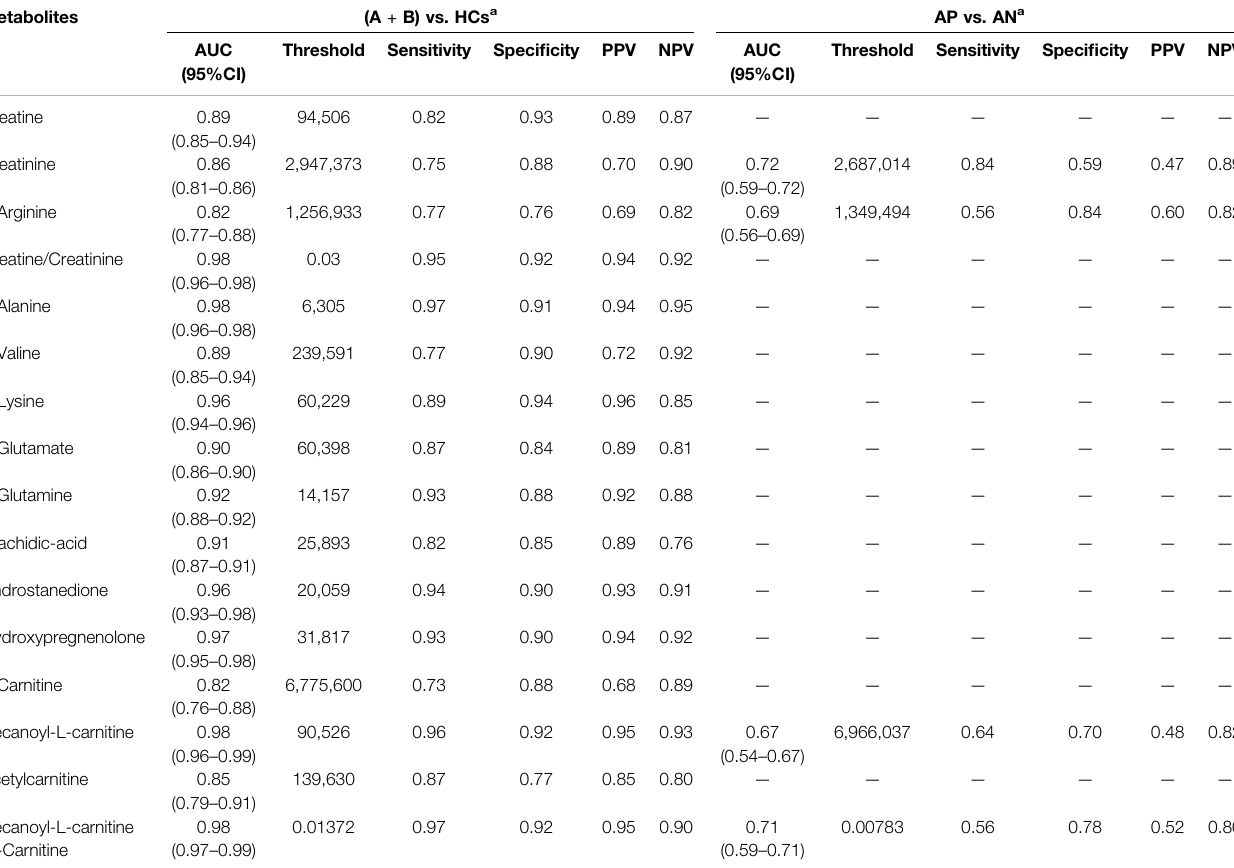
TABLE 4 | Biomarkers for diagnostic of hypopituitarism and biomarkers for prediction of gonadotropin replacement therapy. Metabolites